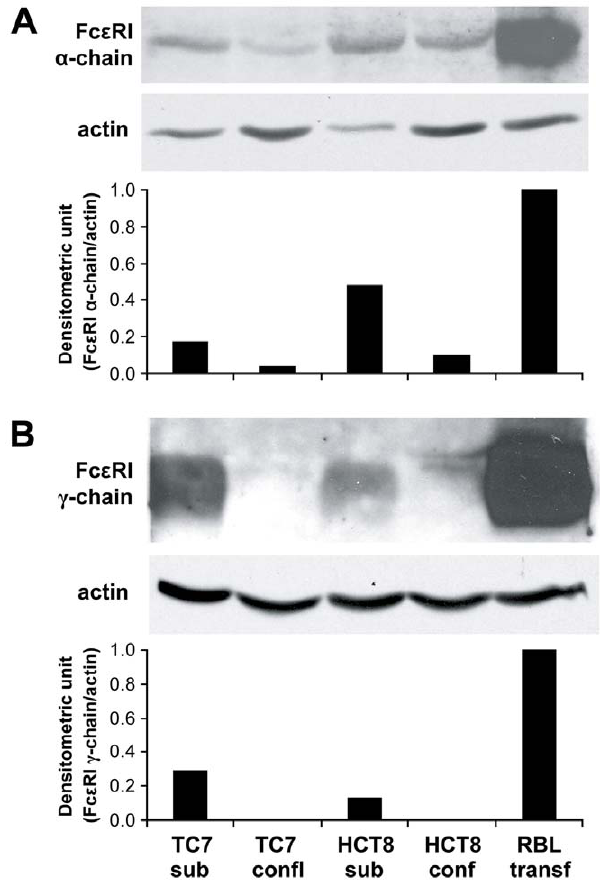
Figure 8. Western blot analysis reveals Fc e RI in human intestinal tumor cell lines. (A) Fc e RI a -chain and (B) Fc e RI c -chain expression is investigated in Caco2/TC7 and HCT8 subconfluent and confluent cell lines. In all experiments RBL cells transfected with the human Fc e RI receptor served as positive controls and the protein expression signal was normalized to the expression of house-keeping protein actin.